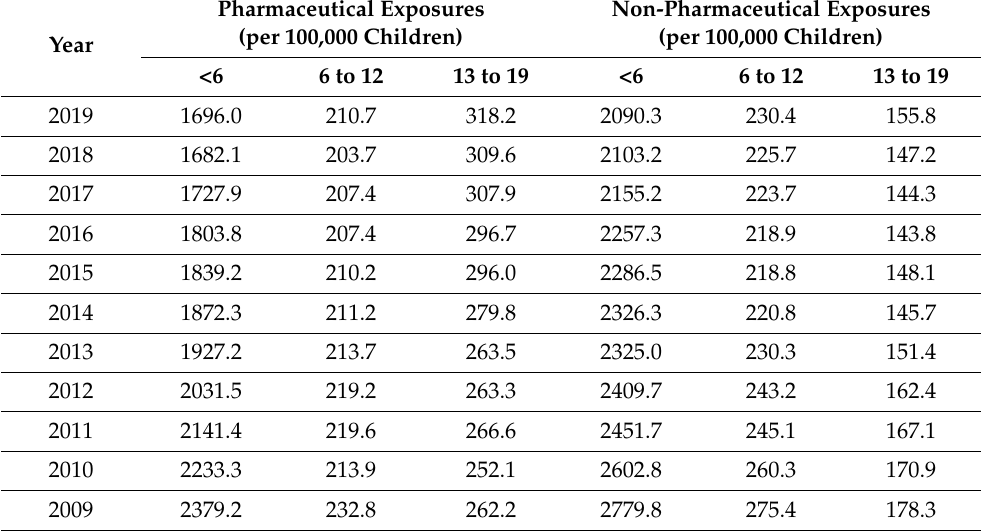
Table 2. Population-adjusted Annual Rates of Poison Exposures per 100,000, by Type and Children Age Range, 2009–2019.